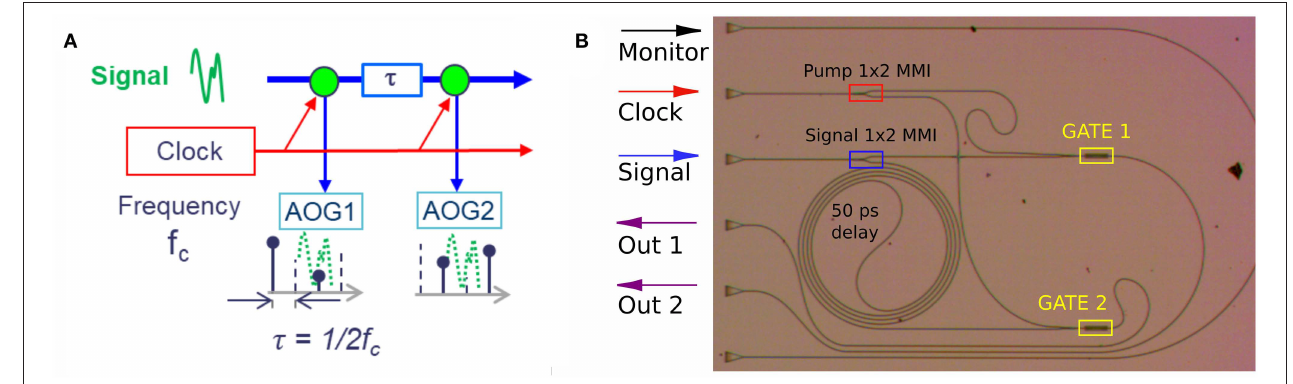
FIGURE 11 | (A) Sketch of all-optical sampling architecture using time interleaving through two AOGs. The clock is set at frequency f c , and the two AOGs are 1 τ -delayed with τ 2 f c , leading to a final sampling rate of 2 f c . (B) Fabricated hybrid silicon photonic circuit for time interleaving through 2 AOGs. The time delay of 50 = ps between the signal inputs fed into each AOG implies a final sampling rate of 10 GS/s. Yellow squares show the location of the hybridized InP PhC nanocavities. Here the AOGs are not in a serial configuration like in (A) , but are fed by the same amount of power after a 1 losses through the delay